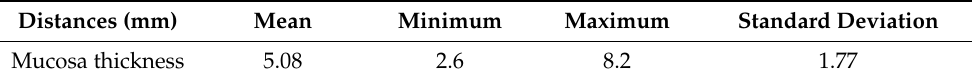
Table 5. Mean, maximum, minimum, and standard deviation of the mucosa thickness above the pterygoid implants.